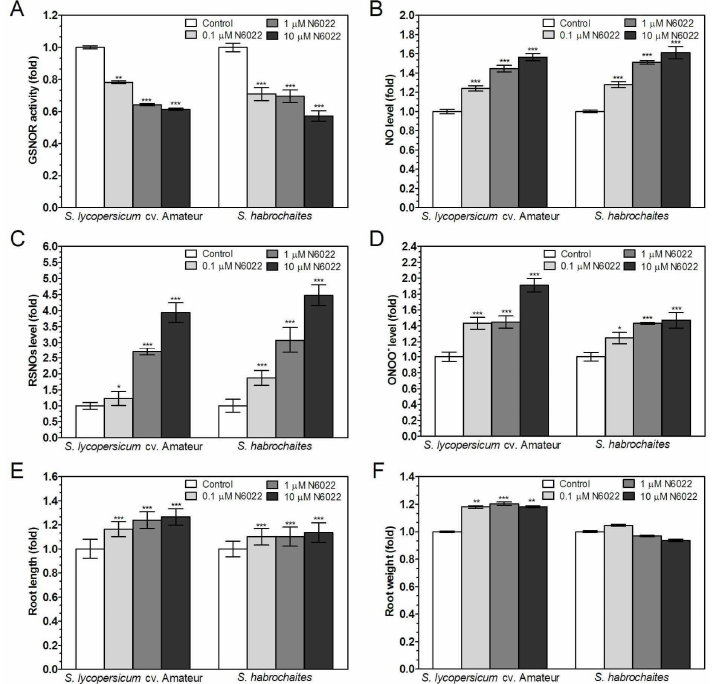
Figure 1. Effects of GSNOR inhibitor N6022 on GSNOR activity, RNS levels and root growth in two Solanum spp. genotypes. Plants were grown in the growth media containing 0, 0.1, 1 and 10 µM N6022. ( A ) GSNOR activity was evaluated spectrophotometrically at 25 °C by monitoring the decrease of NADH absorbance at 340 nm. ( B ) Changes in NO levels in apical parts of roots were monitored by confocal microscopy using 20 µM DAF-FM-DA. ( C ) The S-nitrosothiol content was determined by the modified Saville method at λ = 540 nm. ( D ) Changes in ONOO - levels in apical parts of roots were monitored by confocal microscopy using 20 µM APF. The effect of N6022 was also studied on physiological parameters of ( E ) root length and ( F ) root fresh weight. The data are presented as means ± SD (A-D: n ≥ 3; E–F: n = 30) relative to the value of the tested parameter measured for control plants grown in media without N6022. Significantly different means from the control value are denoted by asterisks (ANOVA, * p < 0.05, ** p < 0.01, *** p < 0.001). 3.3 Effects of GSNOR Inhibition on Plant Root Growth are Mediated by Modulation of NO and S-Nitrosothiol Levels